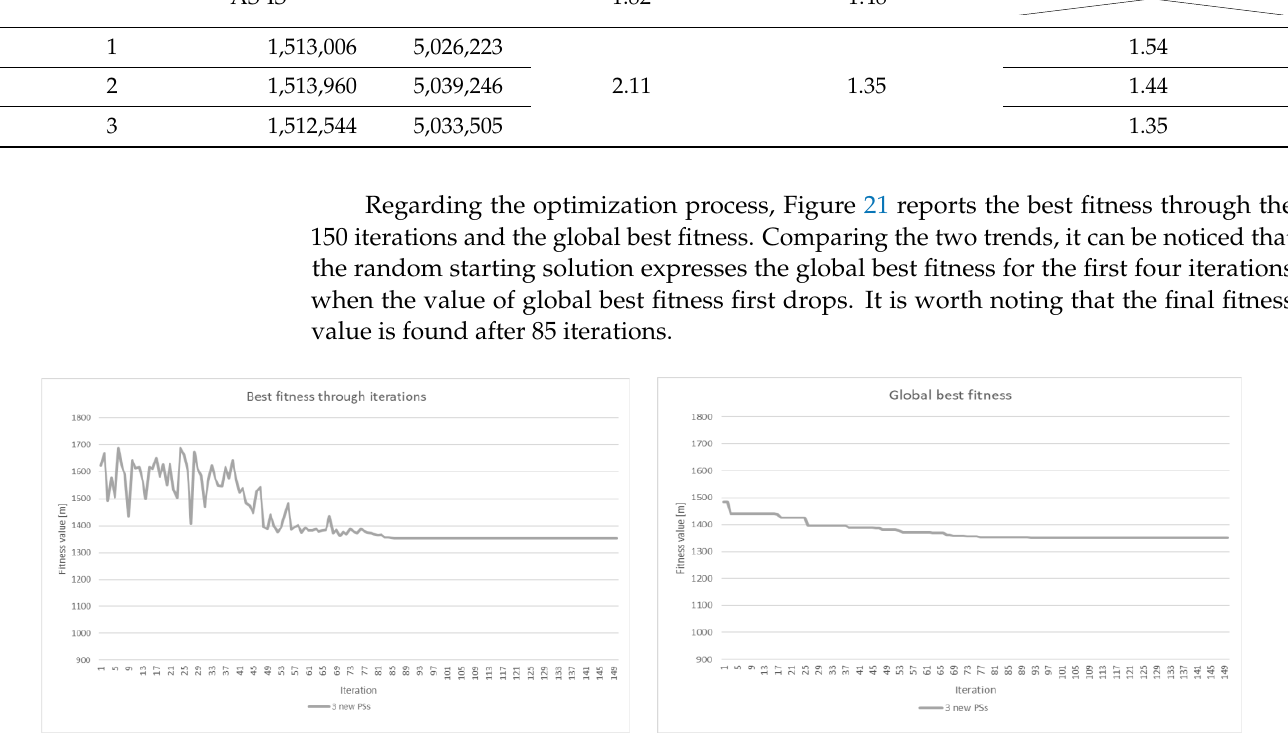
Figure 21. Best fitness through iterations and the global best fitness: three additional PSs.